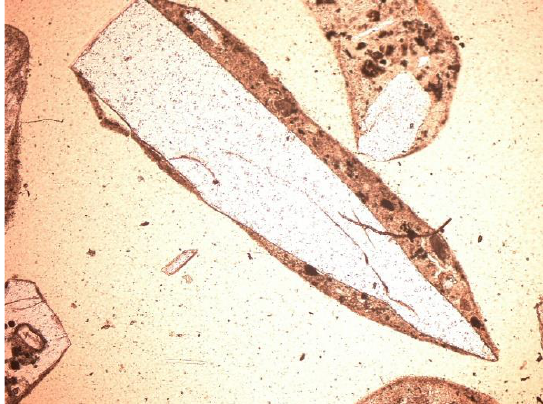
Figure 16. Glass in SP3 slag and ash sample, thin section, 1P, 100×, transmitted light.